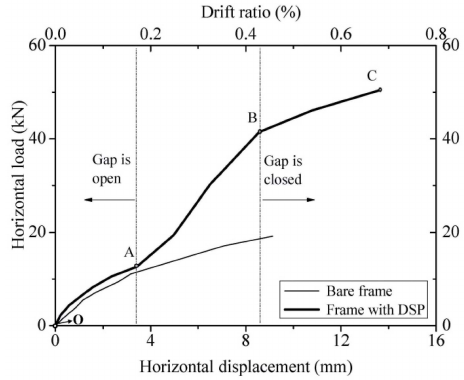
Figure 9. Envelope curves.